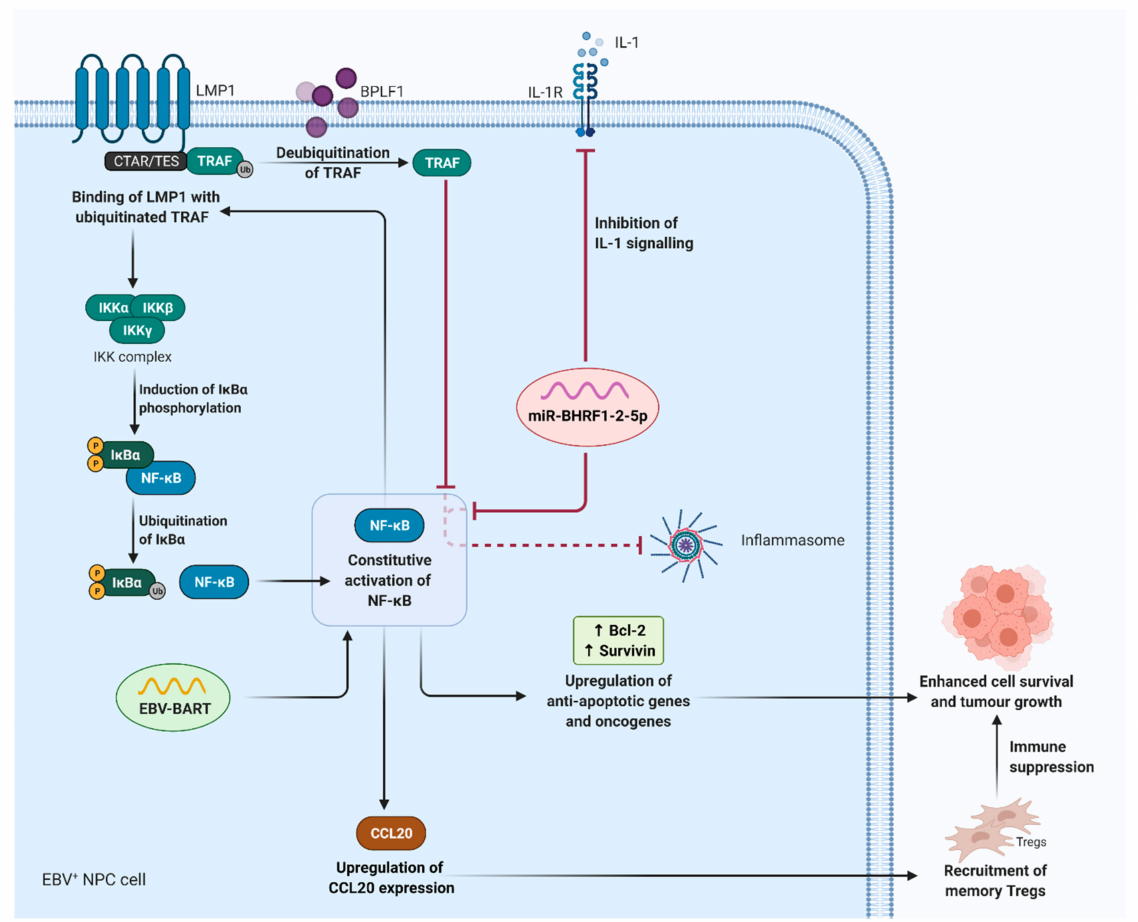
Figure 4. Overview of the role of EBV genes in regulating NF- κ B activation. LMP1 induces a constitutive activation of NF- κ B via interaction of CTAR/TES with ubiquitinated TRAFs, followed by phosphorylation of the I κ B α to sustain latent infection. Meanwhile, NF- κ B upregulates LMP1 expression, creating an amplification loop that displays constitutive NF- κ B activity during EBV latency. Dysregulation of NF- κ B activity may lead to unfavourable immune response such as recruitment of Tregs via upregulation of CCL20 expression. This in turn diminishes cytotoxicity effect of CTLs and results